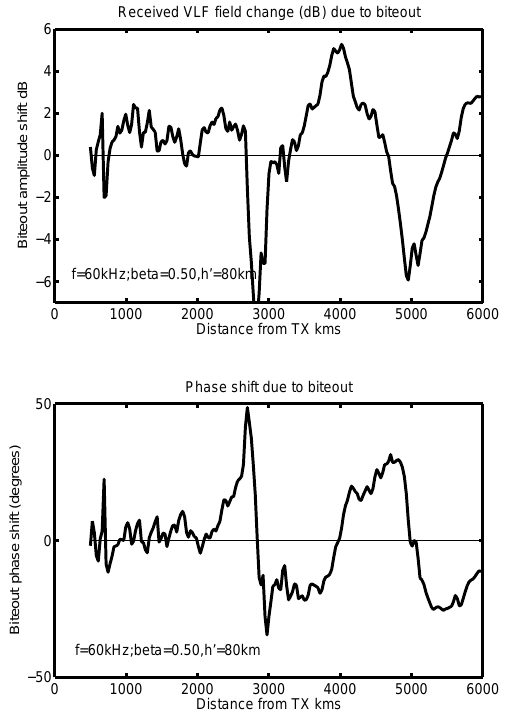
Fig. 8. Change in subionospheric received VLF amplitude and phase due to biteout, at f =60kHz. The general trend is for a posi- tive shift, up to a substantial maximum of 5dB, but with large neg- ative spikes at modal minima. Inside 3000km the shift is between 0 and + 2dB. Phase shifts at large range seem to be ± 20 ◦ , with smaller values up to about 8 ◦ inside